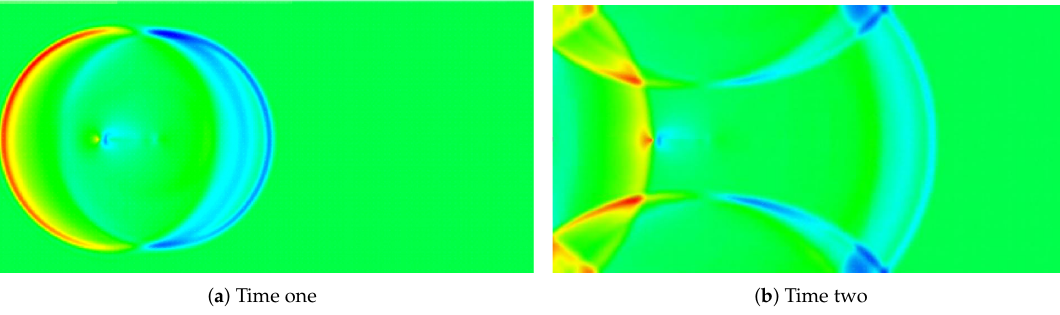
Figure 14. Shockwave propagating within compressible air with compact schemes (from the author’s earlier work Ref.